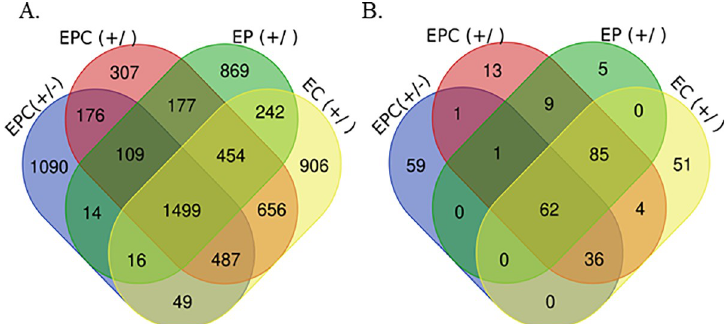
Fig 1. Number of SNPs associated with PTB infection status. The total number of SNPs with moderate (A), or high (B) association with PTB infection status determined by ELISA (E), tissue PCR (P), and tissue culture (C) combinations. Animals were considered cases when they were positive to all the tests, and controls when they were negative to any (+/), or all of them (+/-). A moderate threshold for the association between a SNP and a phenotype was set at a significance level ( α ) between P = 5 × 10 − 5 and P = 5 × 10 − 7 . The high threshold for evidence of an association was set at P < 5 × 10 − 7